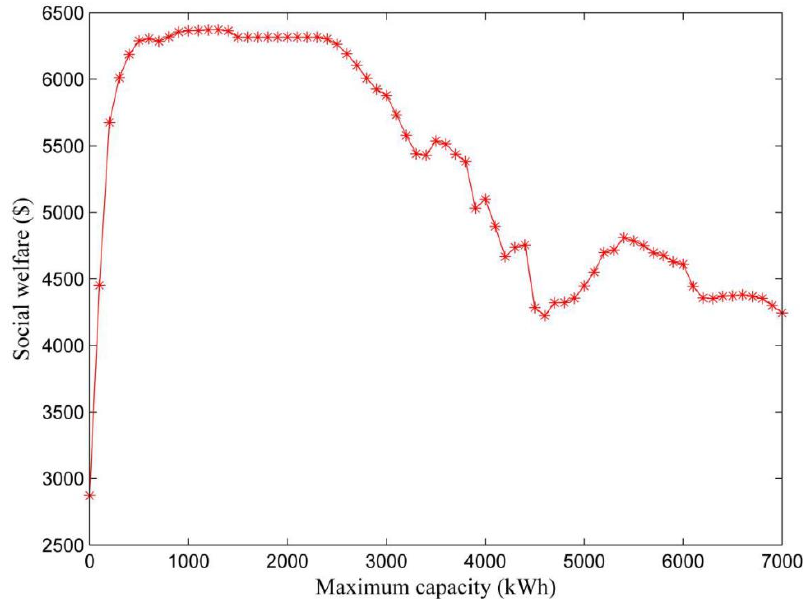
Figure 8. Effects of the maximum storage capacity. Figure 8. E ff ects of the maximum storage